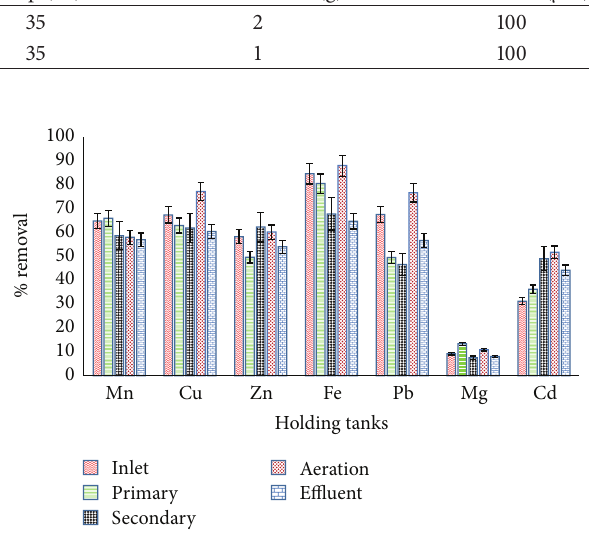
Figure 15: Effect of adsorbent dose on metal removal using Moringa seed pods.